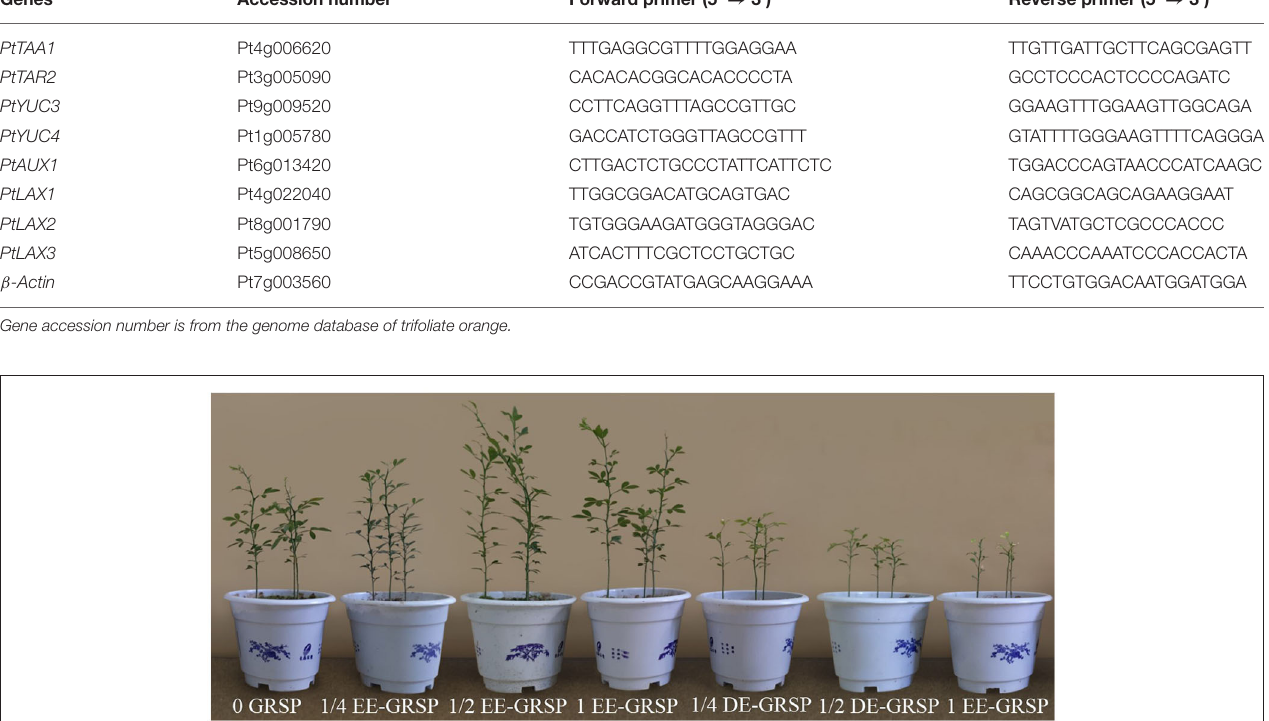
TABLE 1 | Specific primer sequences of genes used in this study for quantitative reverse transcription (qRT)-PCR. Genes